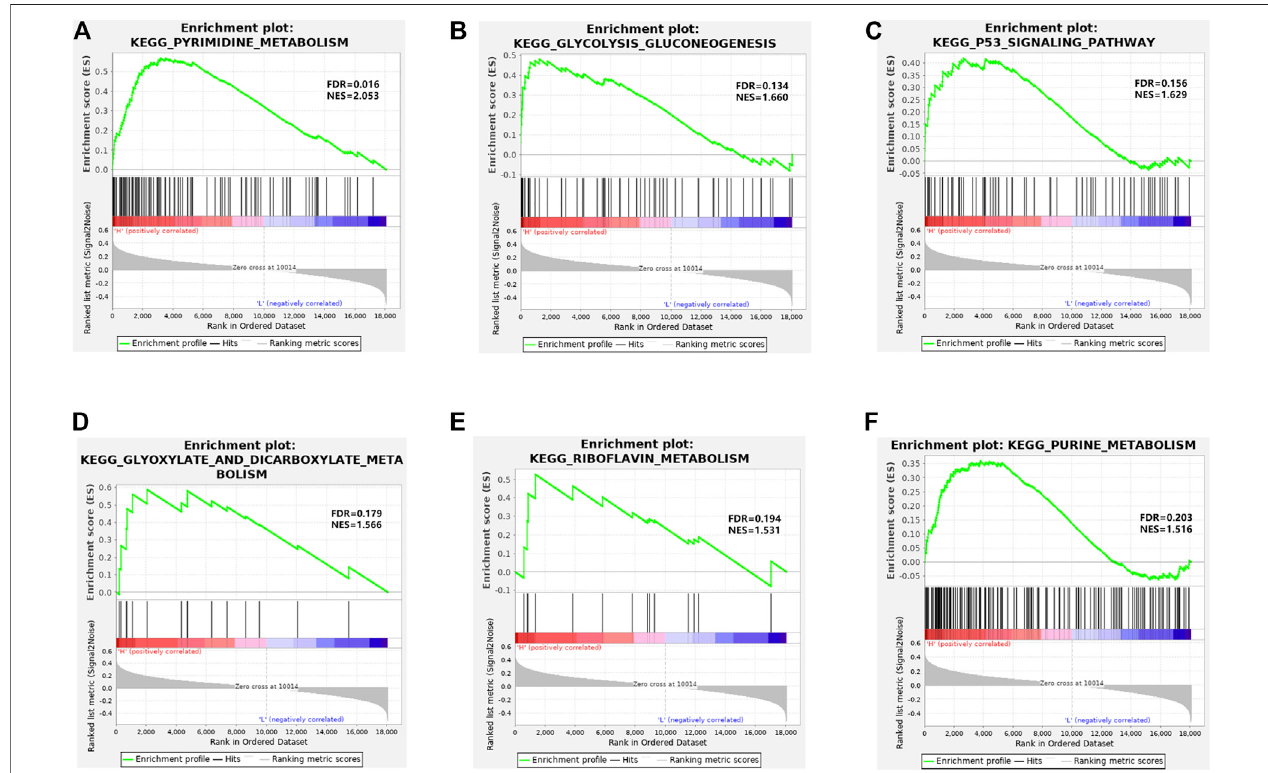
FIGURE 4 | GSEA enrichment analysis. (A – F) Enrichment of high- and low-risk groups in pyrimidine metabolism, glycolysis gluconeogenesis, P53 signaling pathway, glyoxylate and dicarboxylate metabolism, ribo fl avin metabolism, and purine metabolism,